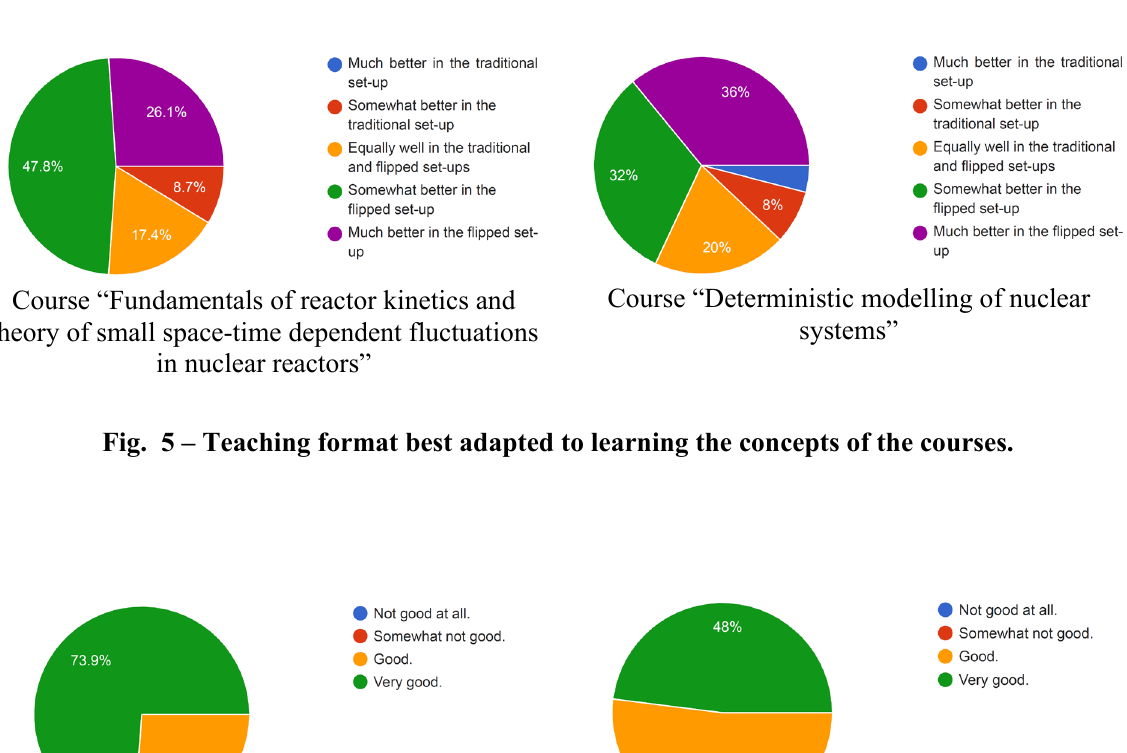
Fig. 4 – Overall impression on the courses.